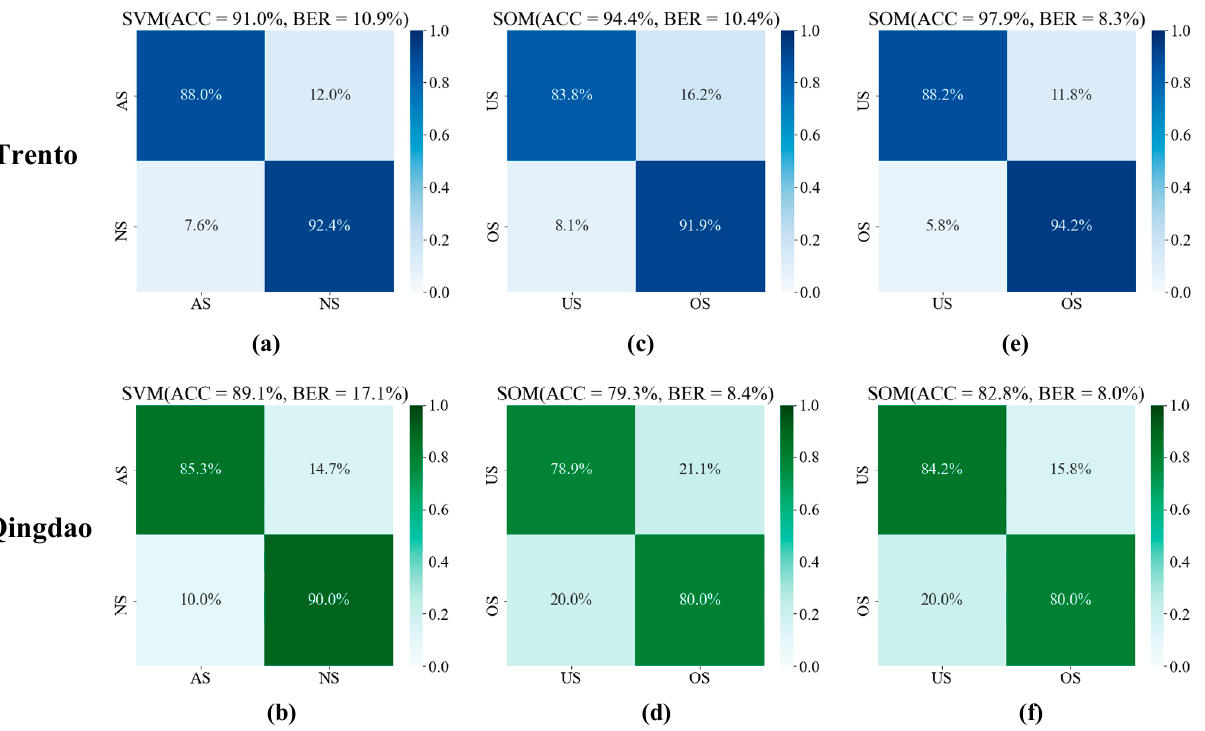
Figure 9. ( a , b ) Results of the SVM classification of normally segmented samples and abnormally segmented samples; ( c , d ) SOM classification results of under-segmented and over-segmented samples, where ( b ) is the result of further classification of SVM test set classification results using SOM directly, and ( e , f ) is the result of further classification of SVM test set classification results after training SOM with samples from the SVM training set. (Note: AS is Abnormal segmentation, NS is Normal segmentation, and US is Under-segmentation, OS is Over-segmentation, ACC is Accuracy, and BER is Balanced Error Rate.).